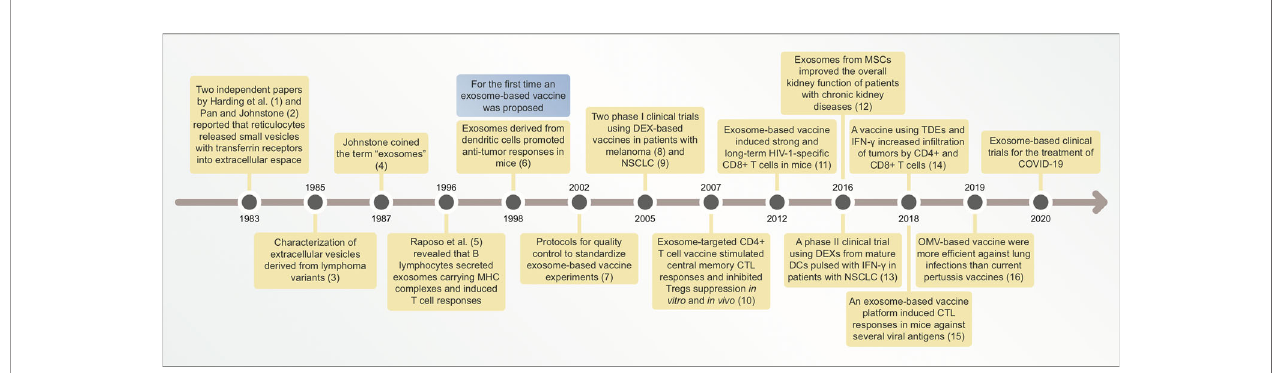
FIGURE 1 | Timeline illustrating main discoveries related to exosome-based vaccines. CTL, cytotoxic lymphocyte; DEXs, exosomes derived from dendritic cells (DCs); NSCLC, non-small cell lung cancer; MSCs, mesenchymal stem cells; TDEs, tumor-derived exosomes; OMV, outer membrane vesicle; COVID-19,